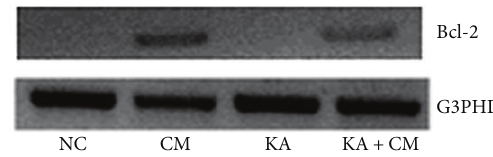
Figure 5: Messenger RNA expression of antiapoptotic factor Bcl- 2 in different treatment groups. Normal control (NC), normal control exposed to HEK conditioned medium (CM), Kainic acid alone treated (KA), and Kainic acid and HEK conditioned medium cotreated (KA +